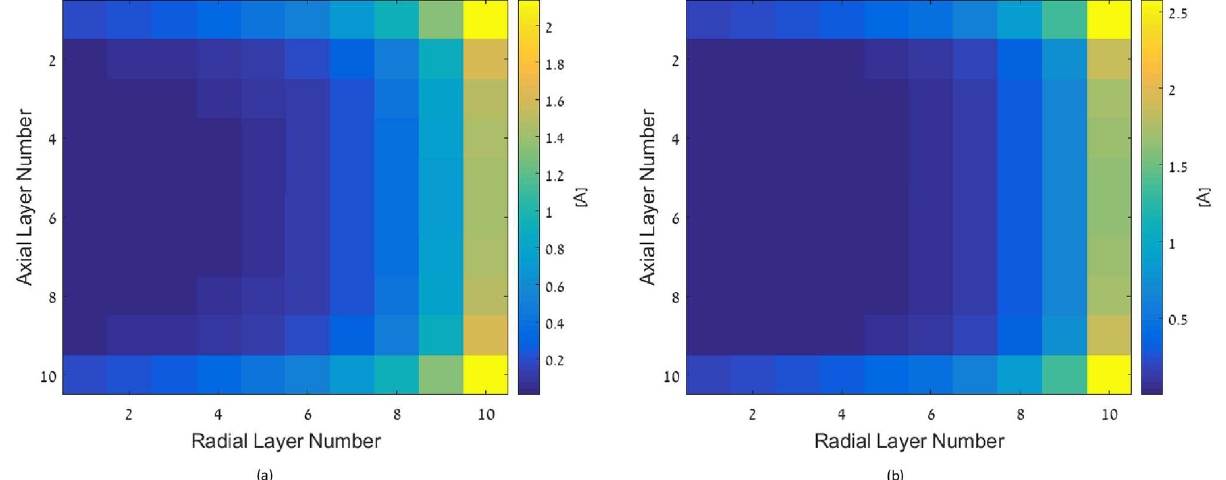
Fig 9. Current distribution in optimal multi-layer solenoid coil: wire radius: (a) 0.1 mm, (b) 0.5 mm.